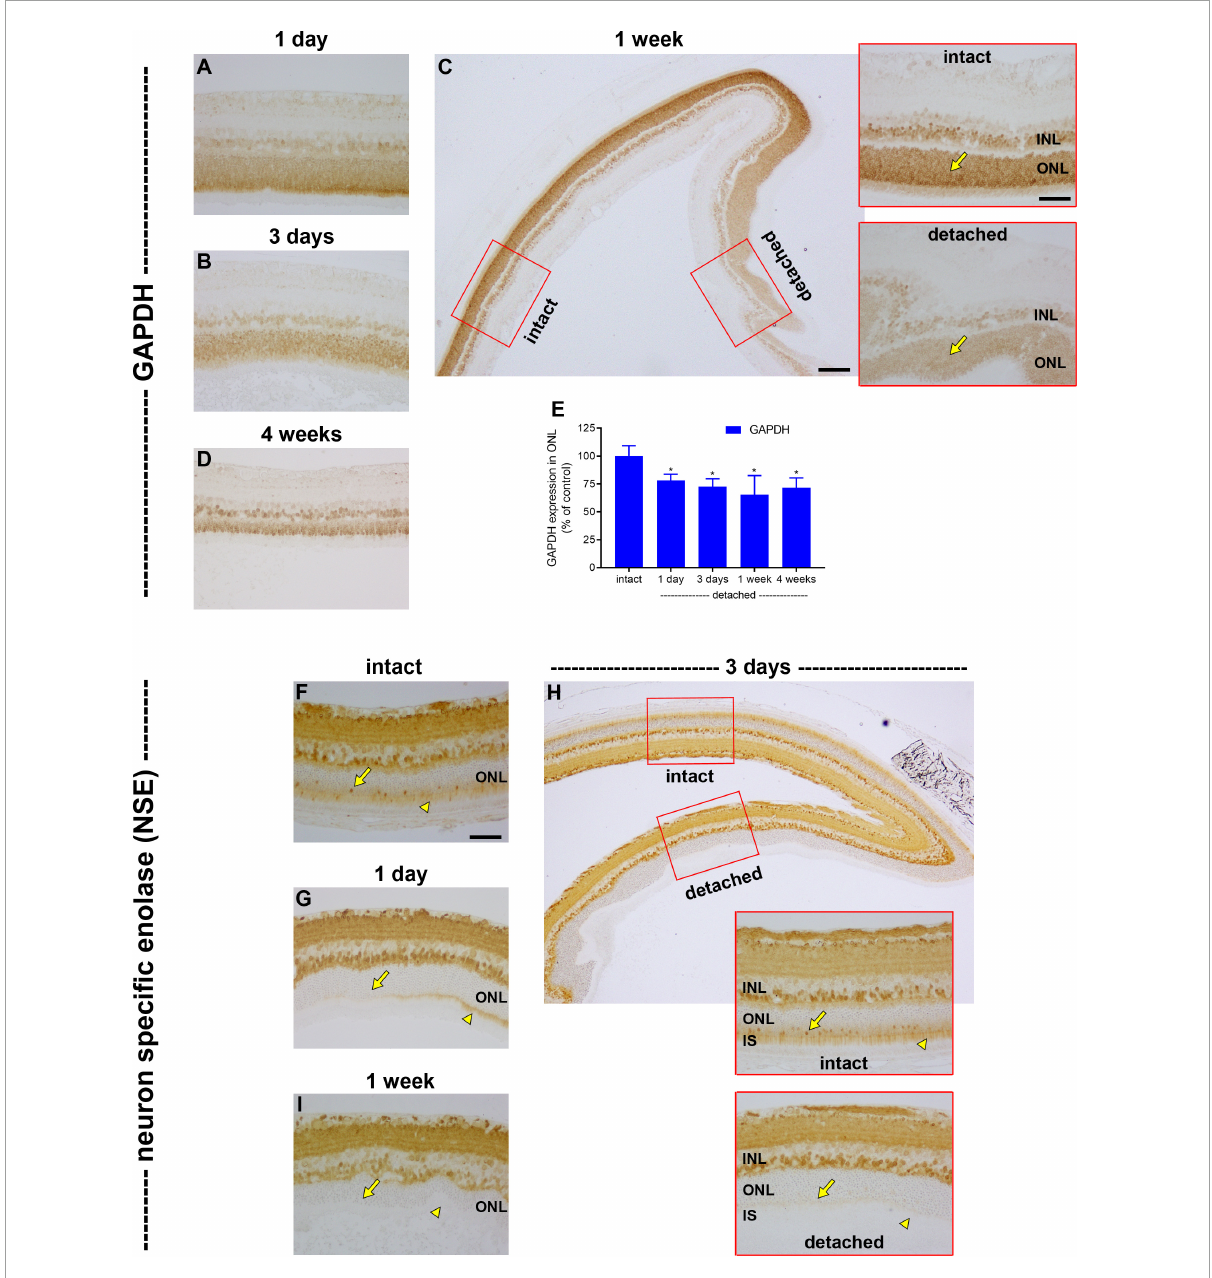
FIGURE7 Effect of retinal detachment on expression of GAPDH and neuron specific enolase (NSE), as evaluated by immunohistochemistry. (A–D) Representative images of GAPDH immunolabelling in intact retina, and at 1 day, 3 days, 1 week, and 4 weeks after detachment. Scale bars: (A,B) (insets) = 60 µ m; (B) (overview) = 150 µ m. (E) Quantification of GAPDH immunoreactivity within the ONL at 1 day, 3 days, 1 week, and 4 weeks after retinal detachment. Values, shown as % of the intact group, represent mean ± SEM. * P < 0.05 by Student’s unpaired t -test followed by modified Bonferroni correction (intact vs. detached). (F–I) Representative images of NSE immunolabelling in intact retina, and at 1 day, 3 days, and 1 week after detachment. In each case, arrowheads highlight photoreceptor inner segments; arrows demarcate photoreceptor cell bodies. Scale bars: (D–F) (insets), (G) = 60 µ m; (F) (overview) = 150 µ